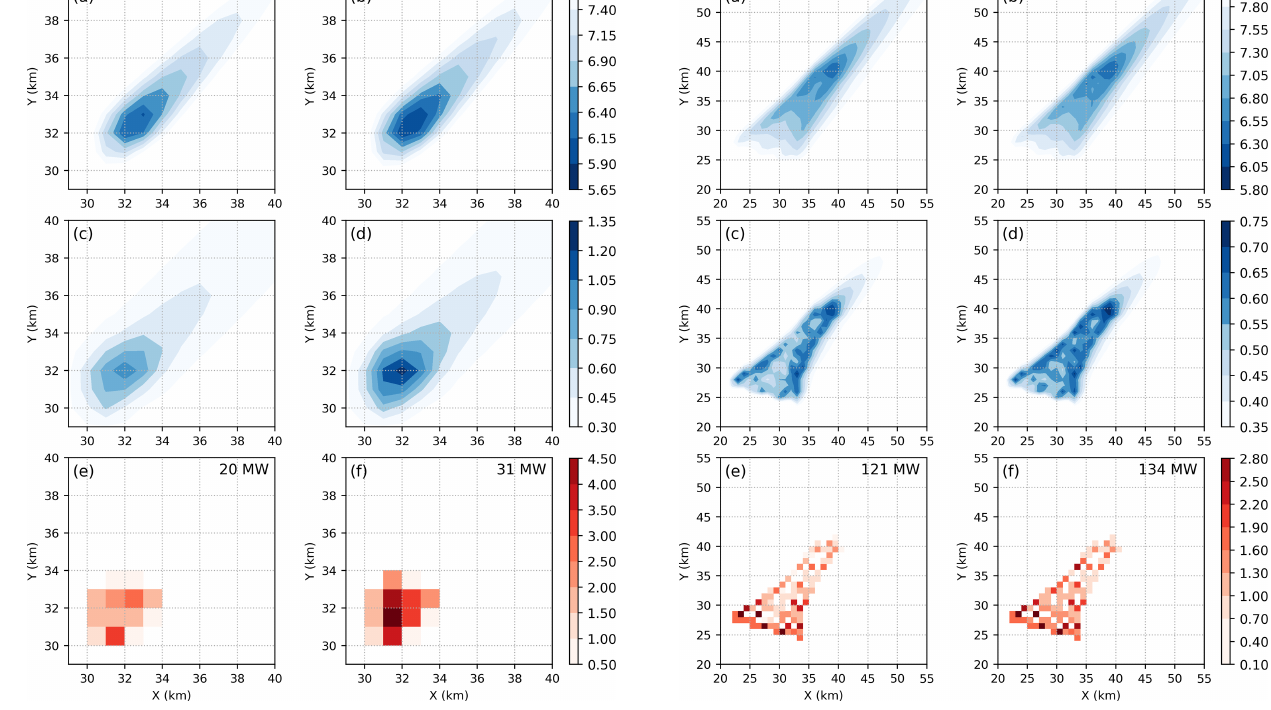
Figure 13. Horizontal cross sections of (a, b) hub-height wind speed (ms − 1 ), (c, d) hub-height TKE (m 2 s − 2 ), and (e, f) power production (MW) at Lillgrund from the Jensen (a, c, e) and Fitch (b, d, f) parameterizations. The results are from WRF with a grid resolution of 1km and wind direction of 222 ◦ .